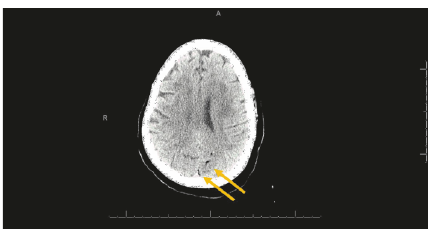
Figure 1: Multiple punctate and curvilinear foci of hypoattenuation in the left hemisphere, likely air within vascular structures given recent hemodialysis (gold